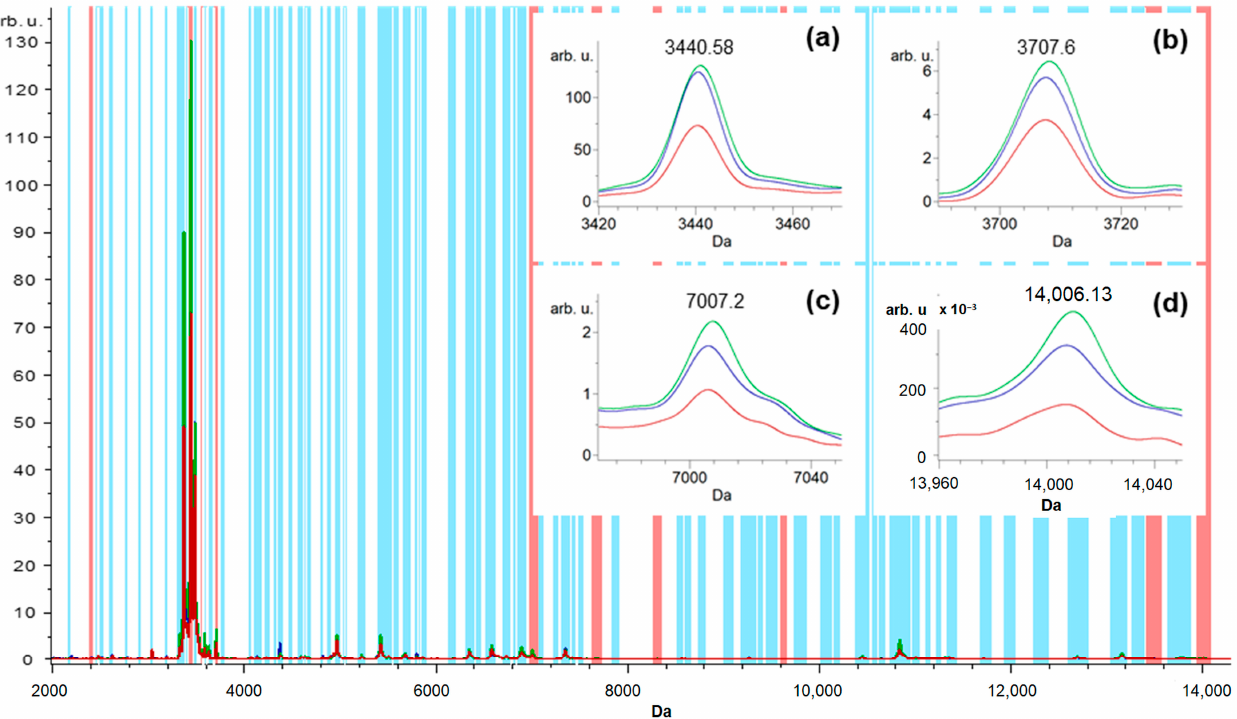
Figure 2. Ten peaks ( m / z 3440.58, 7673.14, 3707.6, 9624.63, 2401.45, 3553.58, 7007.2, 8307.4, 13,460.52, and 14,006.13) were determined by the GA to provide the highest separation power to generate a classification model of the GCF samples. ( a – d ) The zoomed-in total average spectra of several ions displaying differential expression levels in the control (red), FOA (green), and IN (blue) groups of the GCF samples.